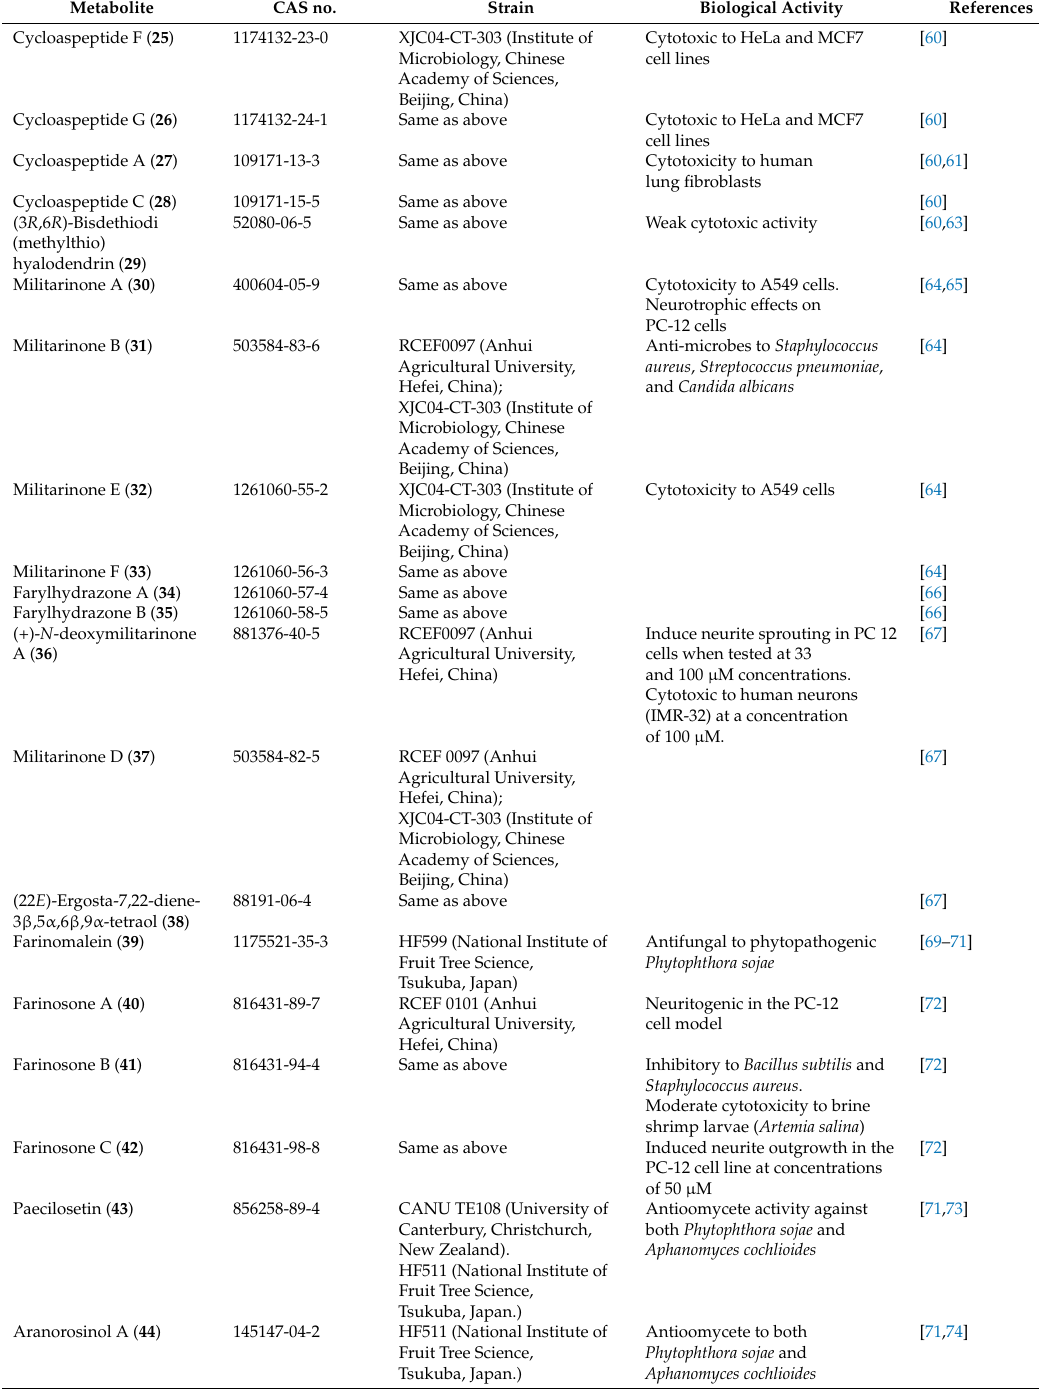
Table 2. Secondary metabolites (SMs) from Isaria farinosa and their biological